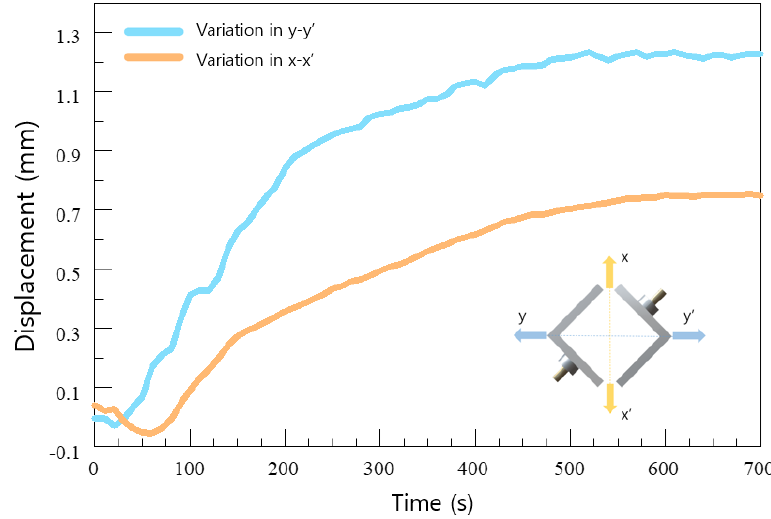
Figure 4. Displacement measured in a laboratory expansion test.